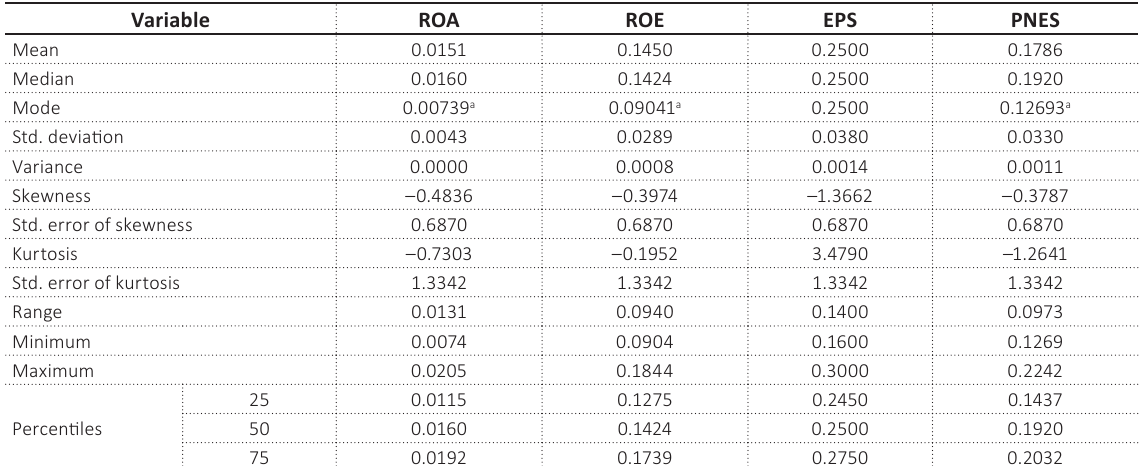
Table 2. Descriptive statistics